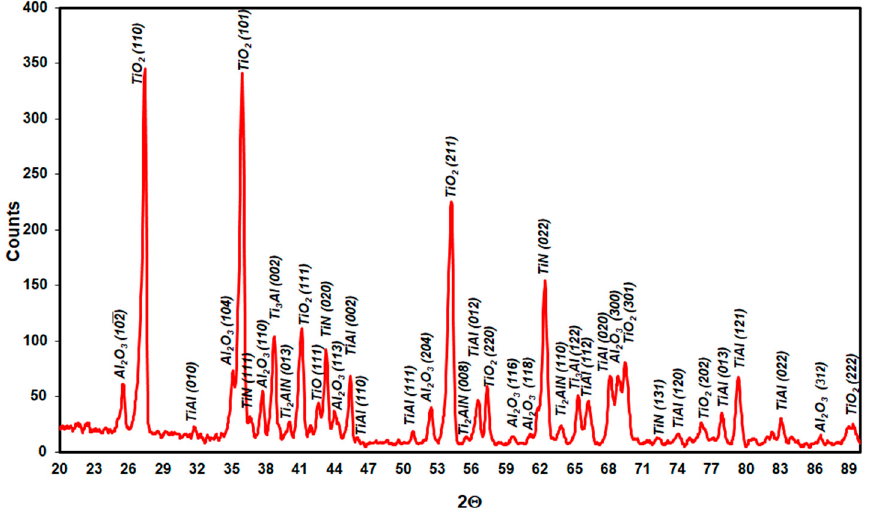
Figure 23. XRD pattern showing the predominant phases formed during oxidation of Ti–46Al–7Nb– 0.7Cr–0.1Si–0.2Ni alloy at 950 °C.